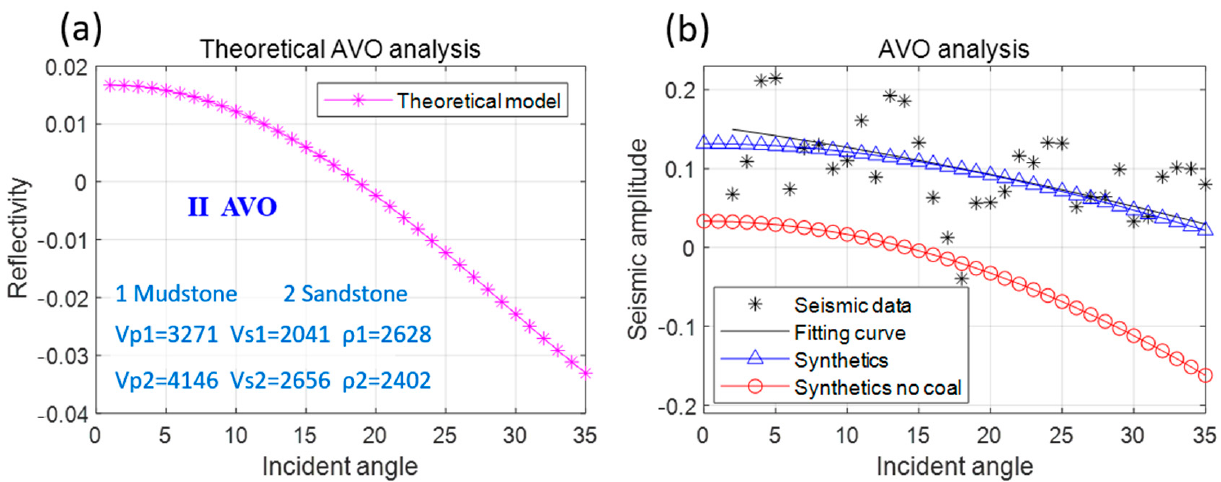
Figure 17. AVO response of the top interface of a gas-bearing sandstone: ( a ) Theoretical analysis; ( b ) AVO analysis.